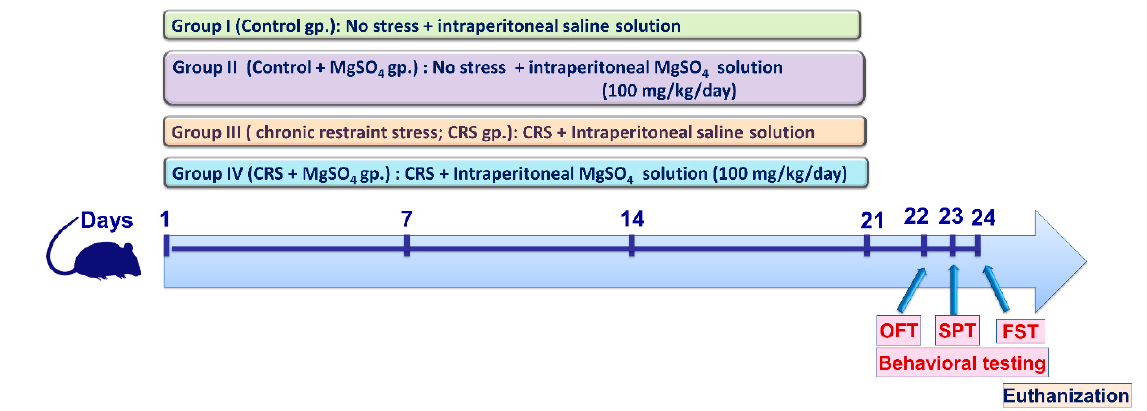
Figure 11. Schematic illustration of the experimental study design. At the end of the experimental period, the behavioral testing was applied starting from the least stressful test in the following order: (1) open-field test (OFT), (2) sucrose preference test (SPT), and (3) forced swimming test (FST), respectively. CRS, chronic restraint stress; MgSO 4 , magnesium sulfate.